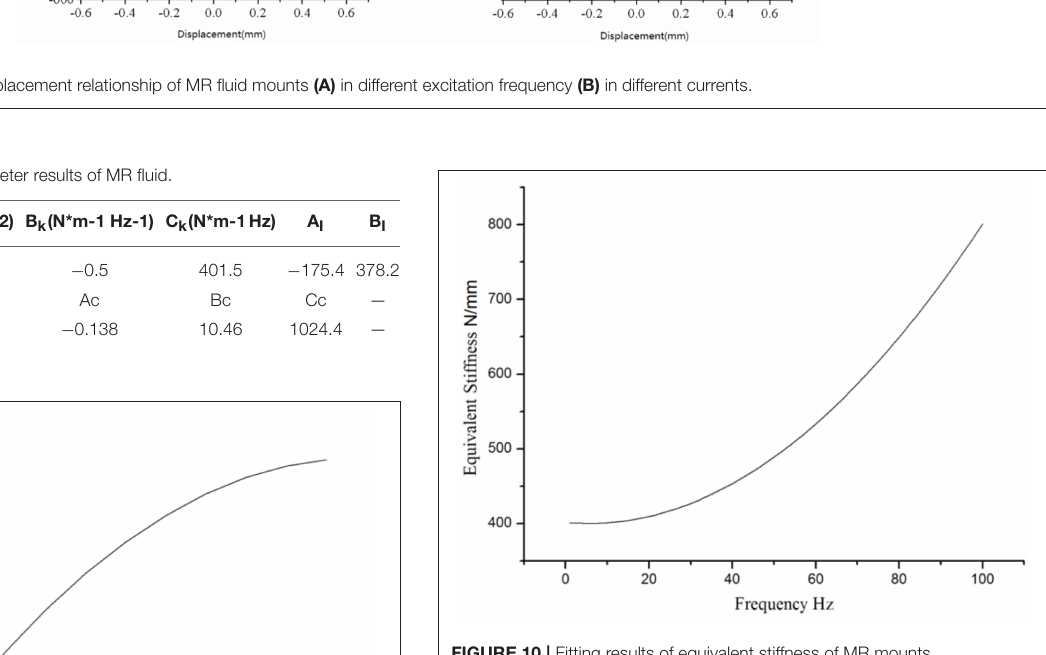
FIGURE 10 | Fitting results of equivalent stiffness of MR mounts.